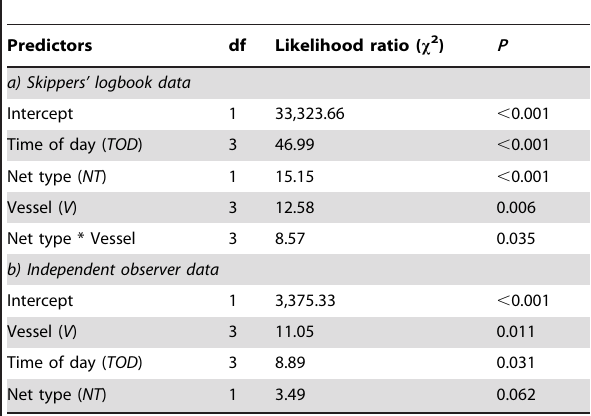
Table 5. Model comparison with the full model (Table 4) for predicting dolphin bycatch by fitting multiple predictors for a) skippers’ logbook data and b) independent observer